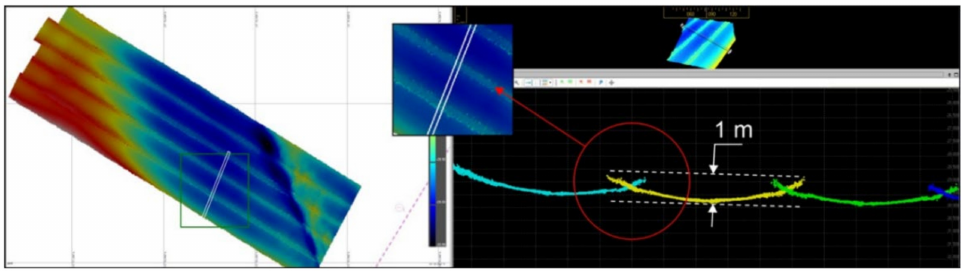
Figure 1. The effect of using incorrect sound velocity values on the accuracy of depth